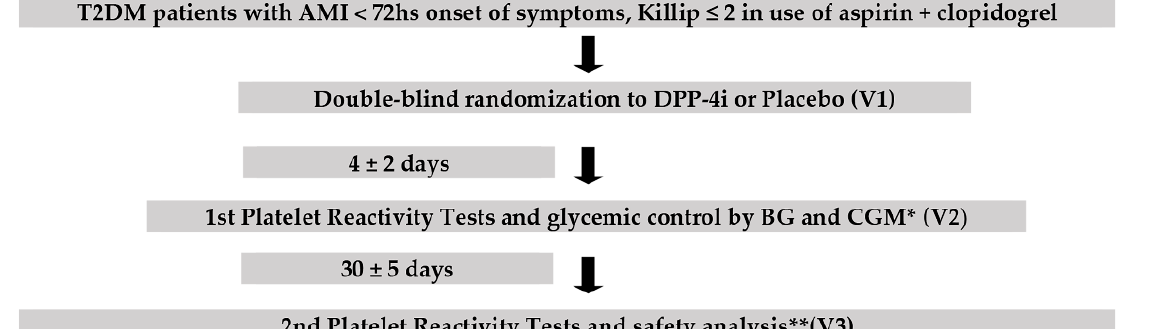
Figure 1. Study design. ** Safety analysis: BNP, pancreatic and hepatic function * CGM: continuous glucose monitoring BG: capillary blood glucose; BNP: B-type natriuretic peptide; T2DM: patients with type 2 diabetes; AMI: acute myocardial infarction; DPP-4i: DPP4 inhibitor; V1 = visit 1; V2 = visit 2; V3 = visit 3.